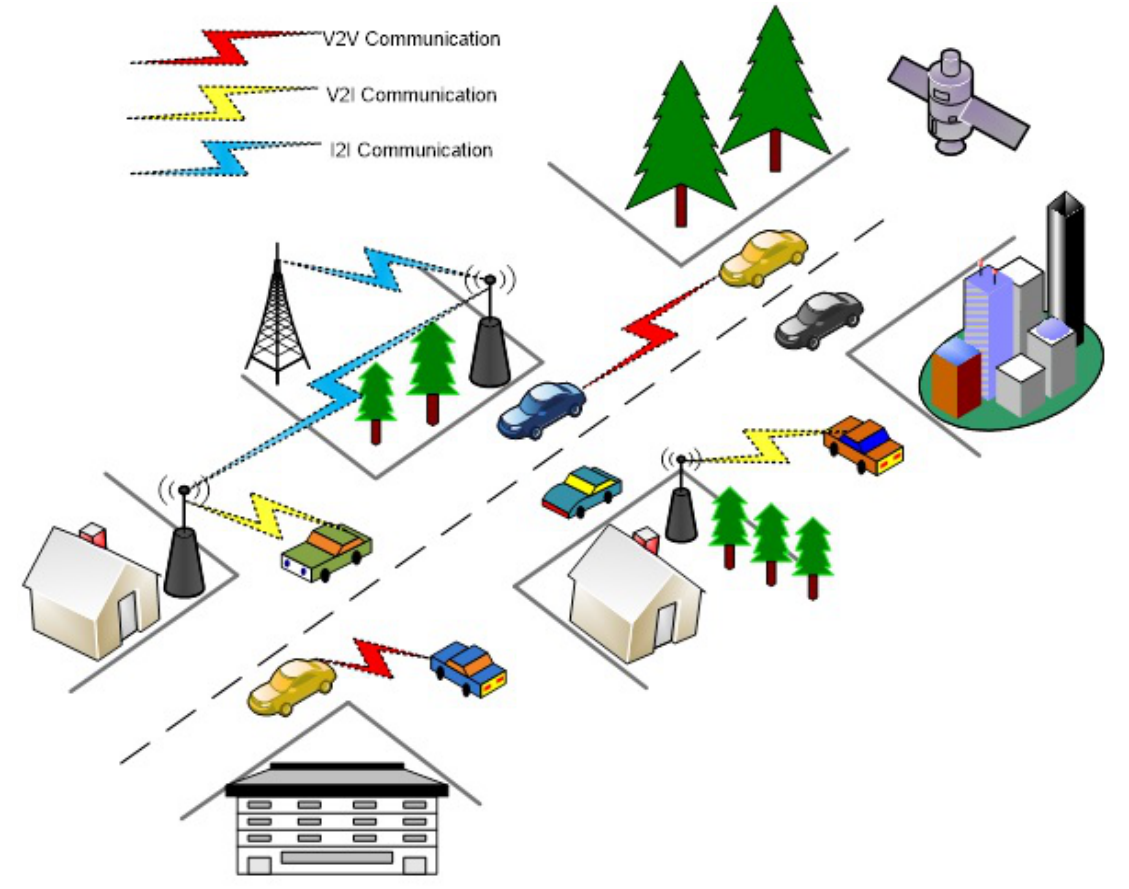
Figure 1. A model of vehicular